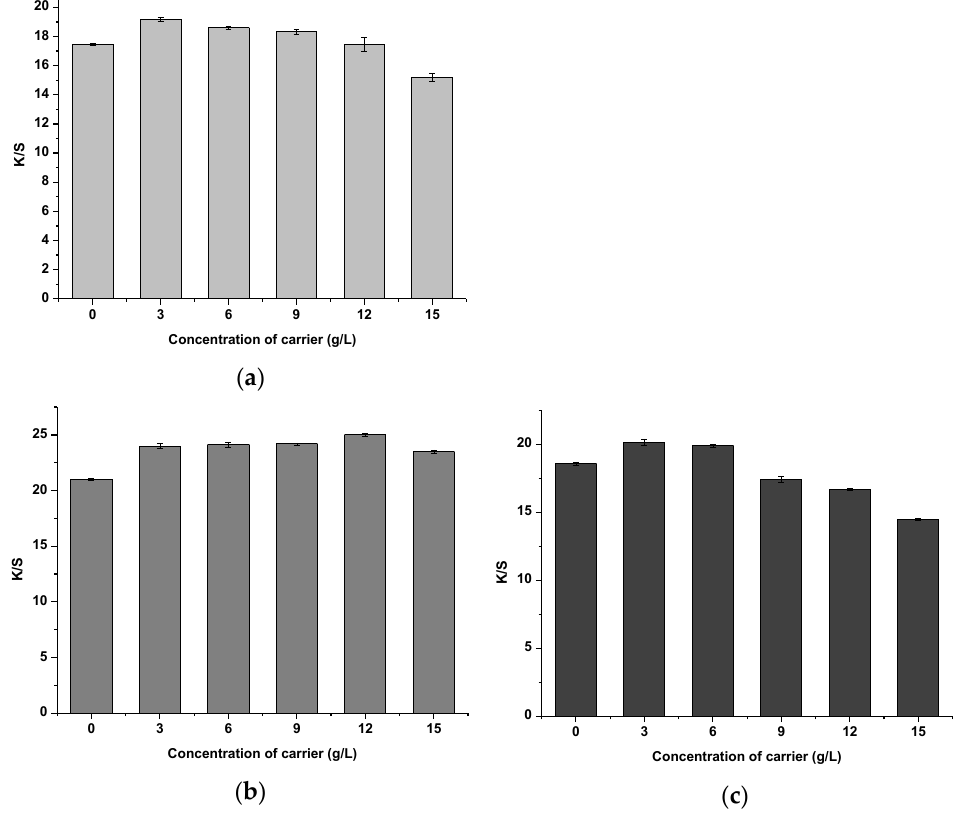
Figure 10. Effect of carrier concentration on the color yield (K/S) of bicomponent filaments dyed with: Figure 10. E ff ect of carrier concentration on the color yield (K / S) of bicomponent filaments dyed with: ( a ) Dye #H; ( b ) Dye #M; ( c ) Dye #L (pH = 7, Temperature = 110 °C, Time = 50 min). ( a ) Dye #H; ( b ) Dye #M; ( c ) Dye #L (pH = 7, Temperature = 110 ◦ C, Time = 50